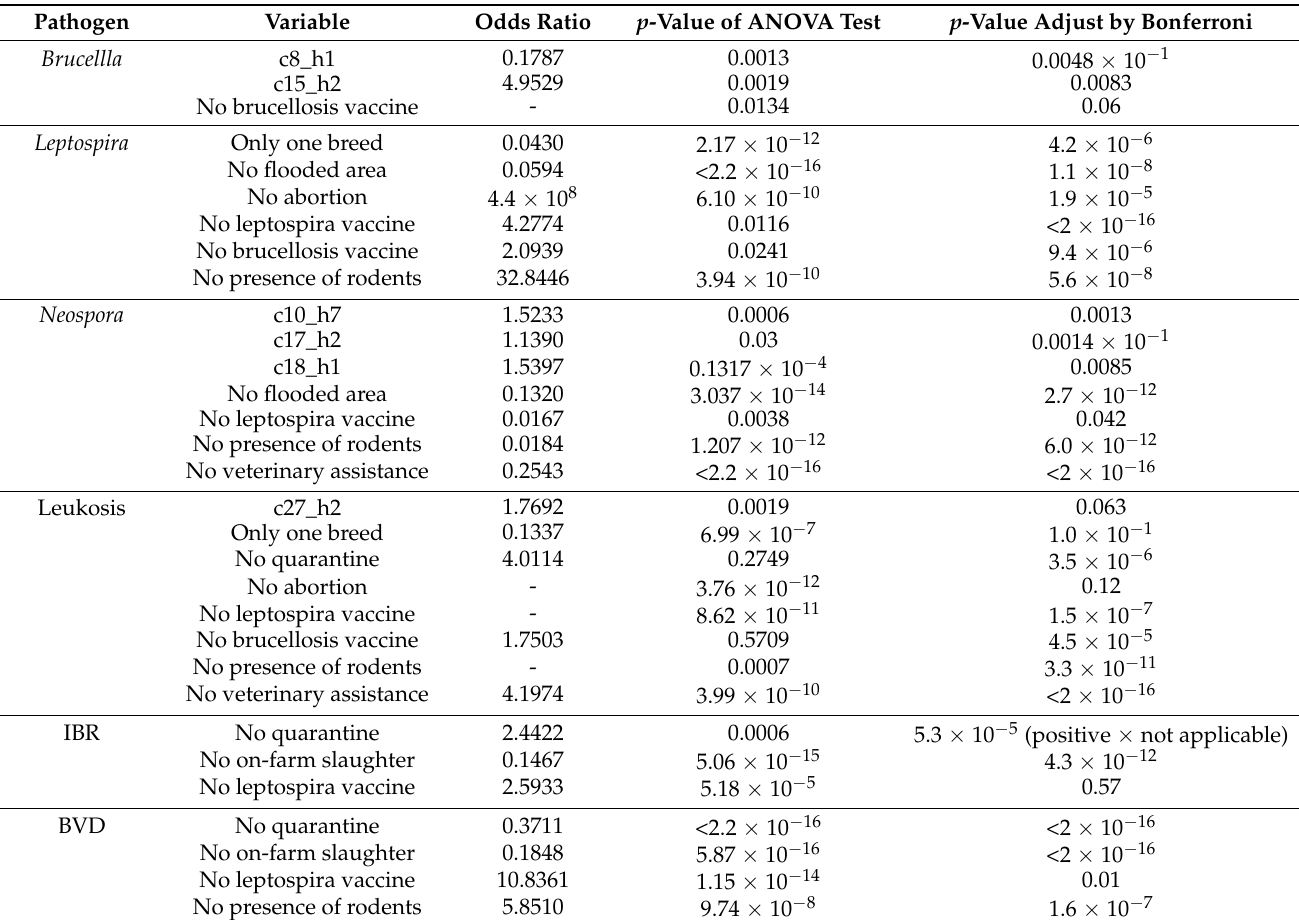
Table 7. Variables included in the logistic regression model and Bonferroni adjust p-value for disease status and epidemio- logical and SNP haplotype variables in Curraleiro P é -Duro cattle.